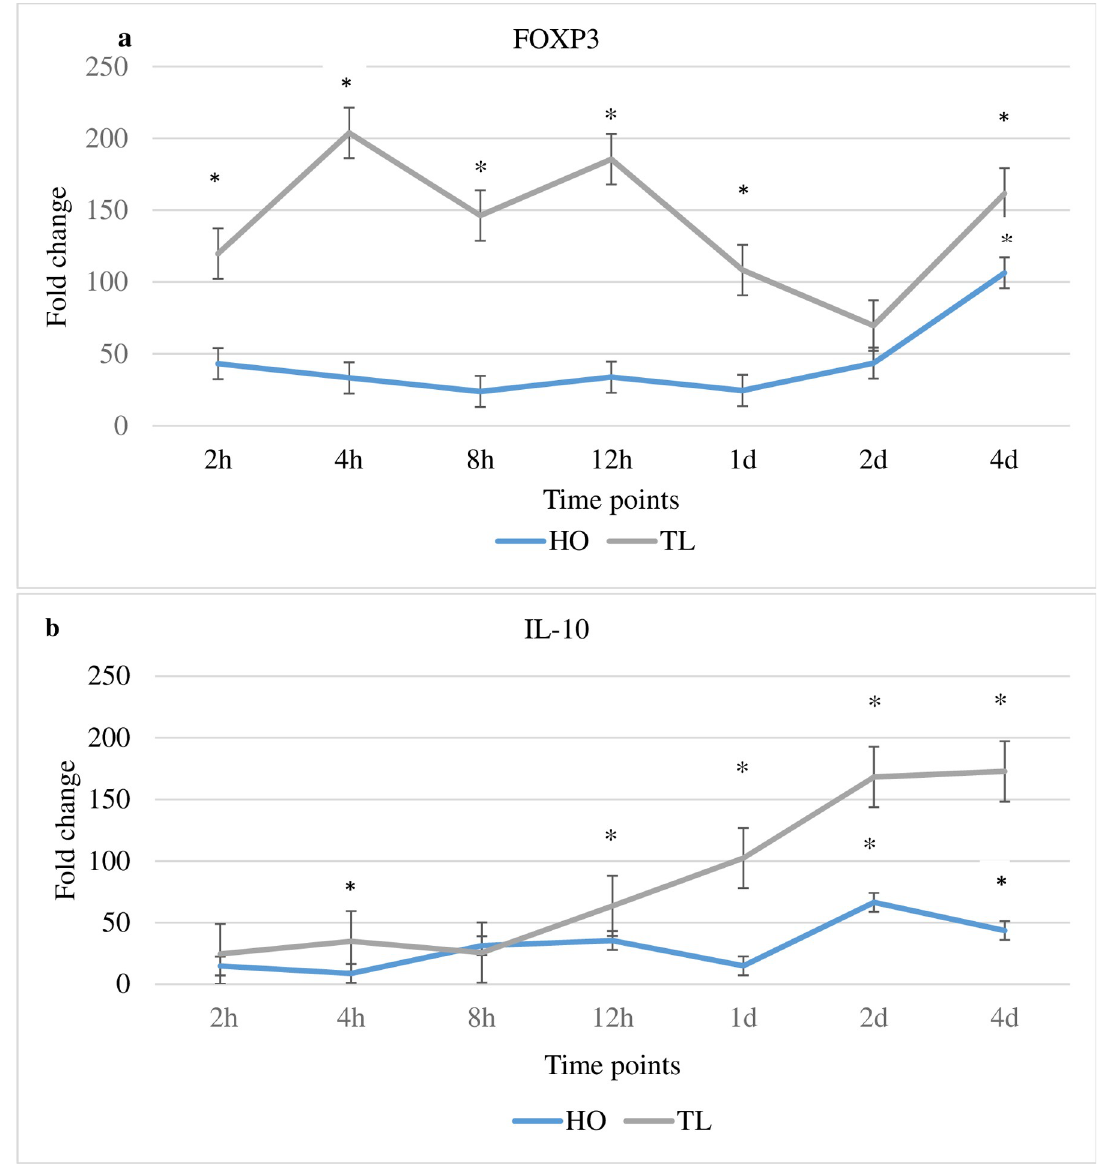
Fig 5. Transcription levels of FOXP3 and IL-10. The figure shows the mean fold change of the genes in M . cerebralis exposed HO and TL fish. Lines are the mean fold change of FOXP3 and IL-10 measured at different time points post exposure hpe/dpe. All HO and TL means are presented normalized to HO and TL timed levels of control fish ± SD (n = 5). ± SD (n = 5), � = significantly higher and § = significantly lower to values in non-exposed fish (p <